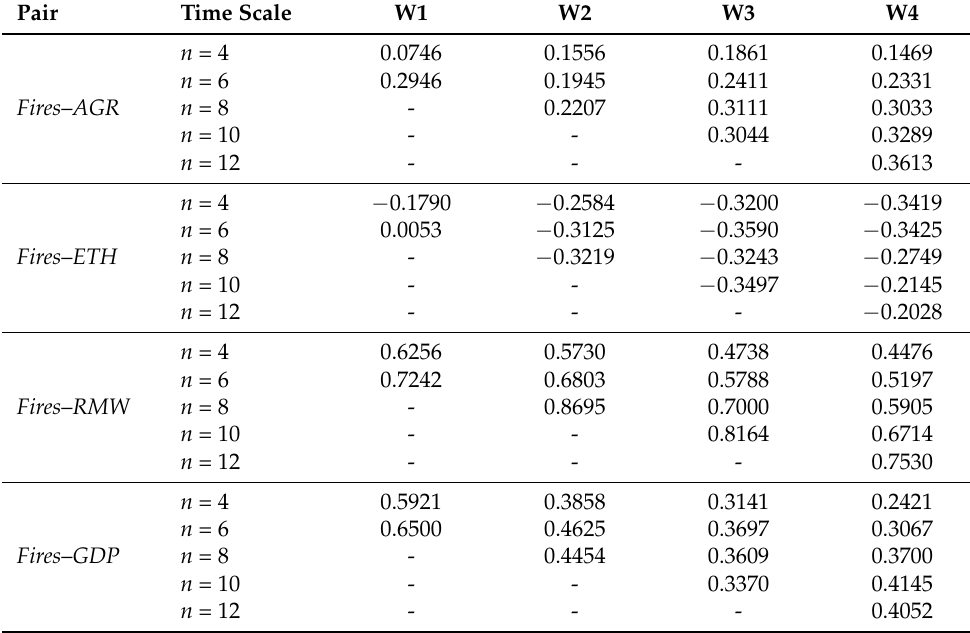
Table A1. The critical values of ∆ ρ DCCA with 95% confidence level for W1 to